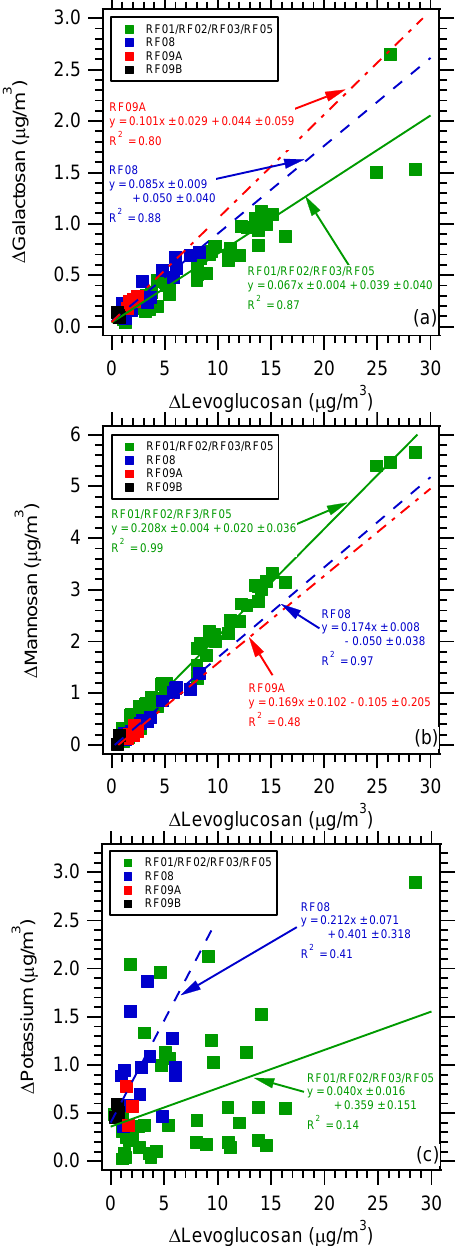
Figure 5. Correlation of (a) 1 galactosan vs. 1 levoglucosan, (b) 1 mannosan vs. 1 levoglucosan, and (c) 1 potassium vs. 1 levoglucosan for all flights with the data segregated by fire lo- cation. Uncertainties with the least-square regressions are one stan- dard